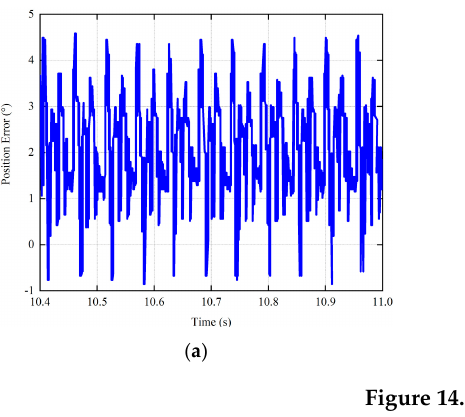
( a ) Current response in d axis before compensation; ( b ) Current response in d axis after compensation;